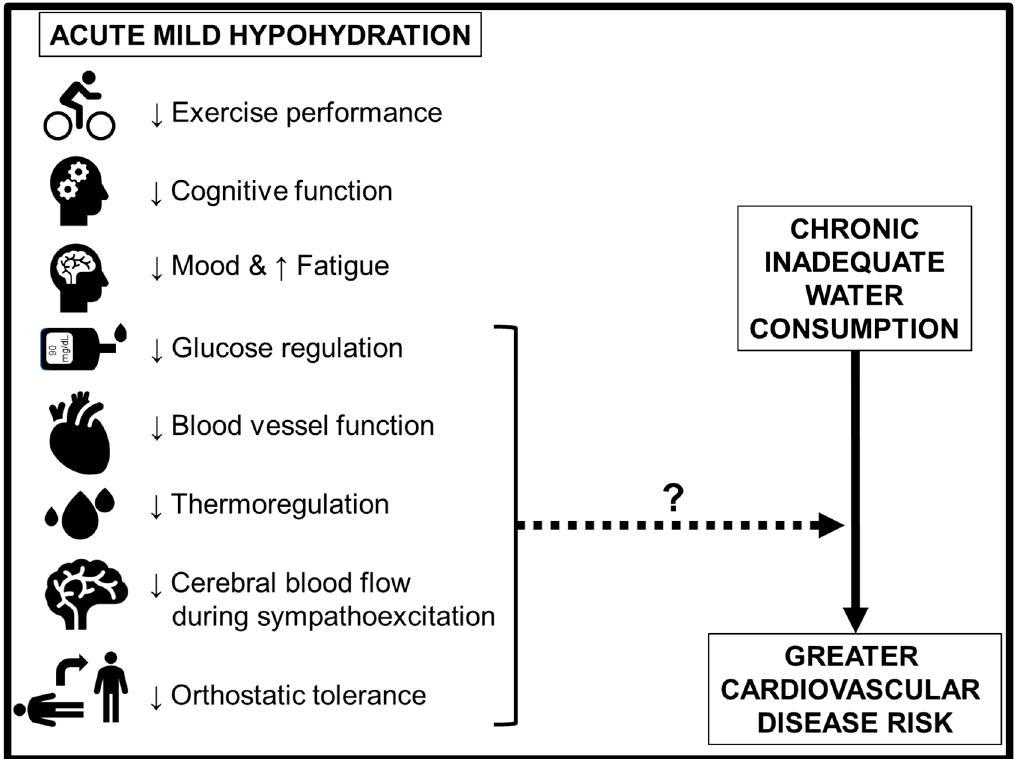
Figure 1. Summary of the physiological consequences of acute mild hypohydration in healthy humans. Further research is necessary to determine whether and how these acute effects influence the poor cardiovascular health outcomes associated with chronic inadequate water consumption. ↓ , impaired or reduced; ↑ , increased.